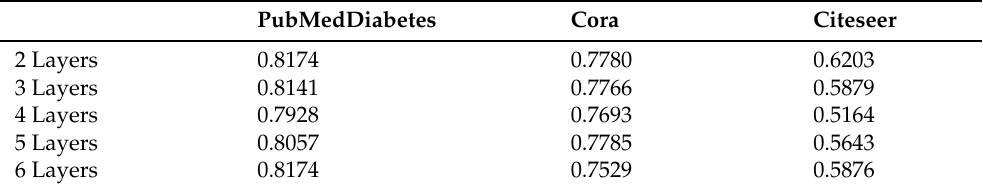
Figure 4. Accuracy for different networks varying the number of epochs with a different number of layers. Table 11. The test accuracy (F1 score) of Inf ACom – GCN using different numbers of